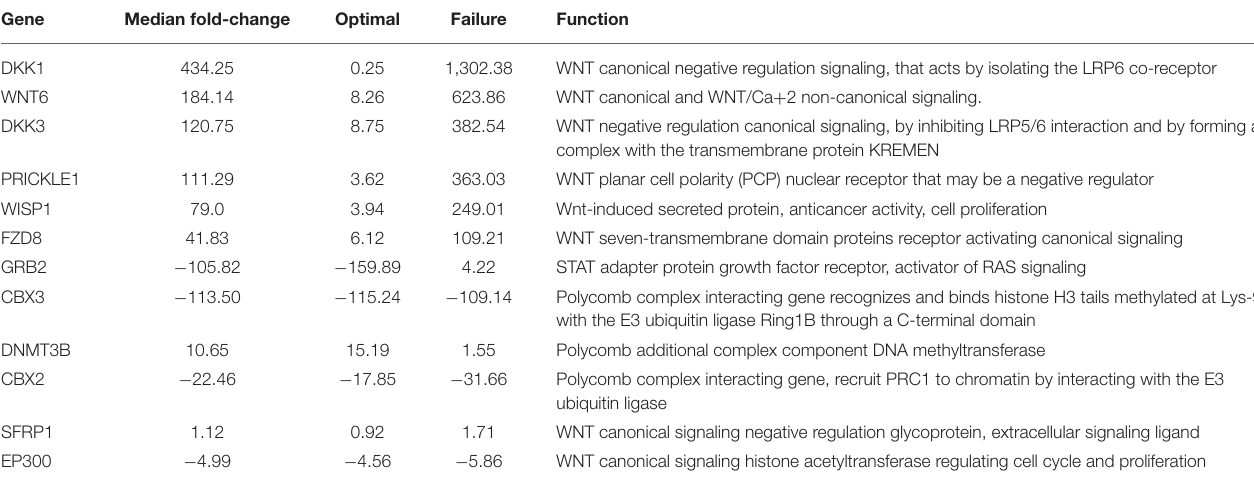
TABLE 4 | Genes scored in the principal component analysis. Gene Median fold-change Optimal Failure